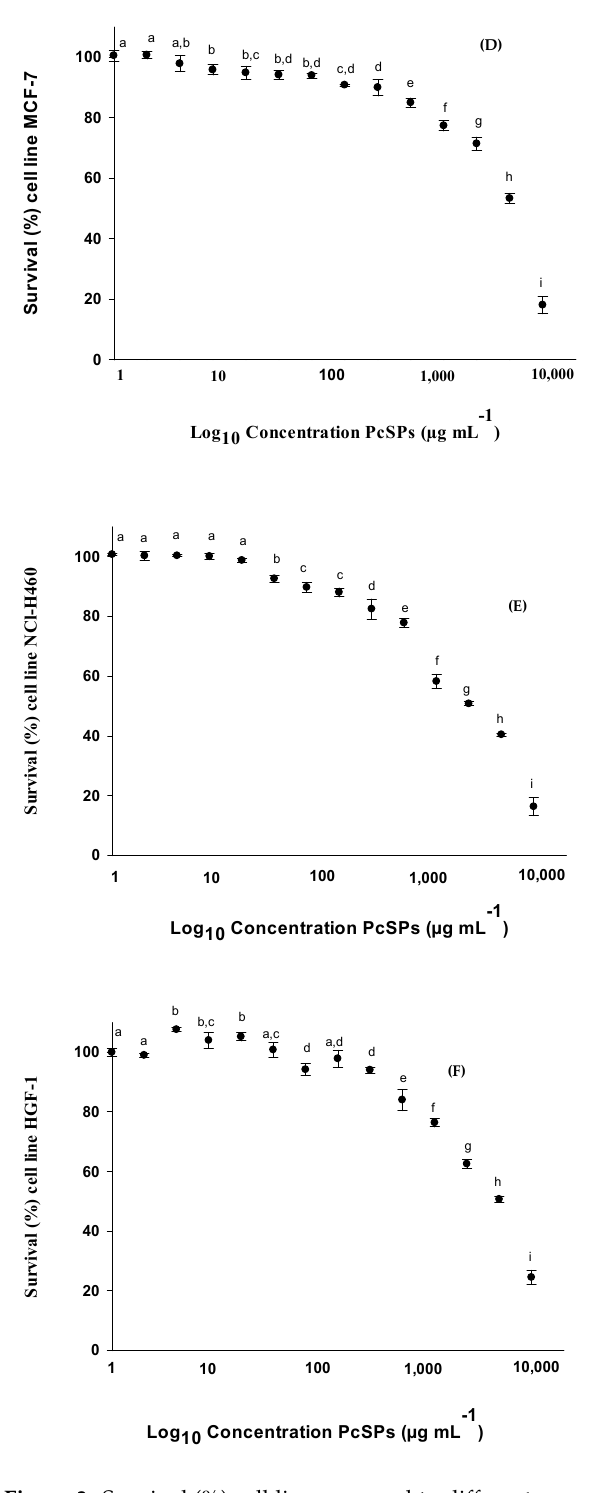
Figure 3. Survival (%) cell lines exposed to different concentrations of PcSPs. ( A ) Survival (%) of HTC-116 cell line; ( B ) Survival (%) of U-937 cell line; ( C ) Survival (%) of HL-60 cell line; ( D ) Survival (%) of MCF-7 cell line, ( E ) Survival (%) of NCI-H460 cell line and ( F ) Survival (%) of HGF-1 cell line. Different points with the same letter correspond to different concentrations with no significant differences between them (post-hoc Tukey HSD test).